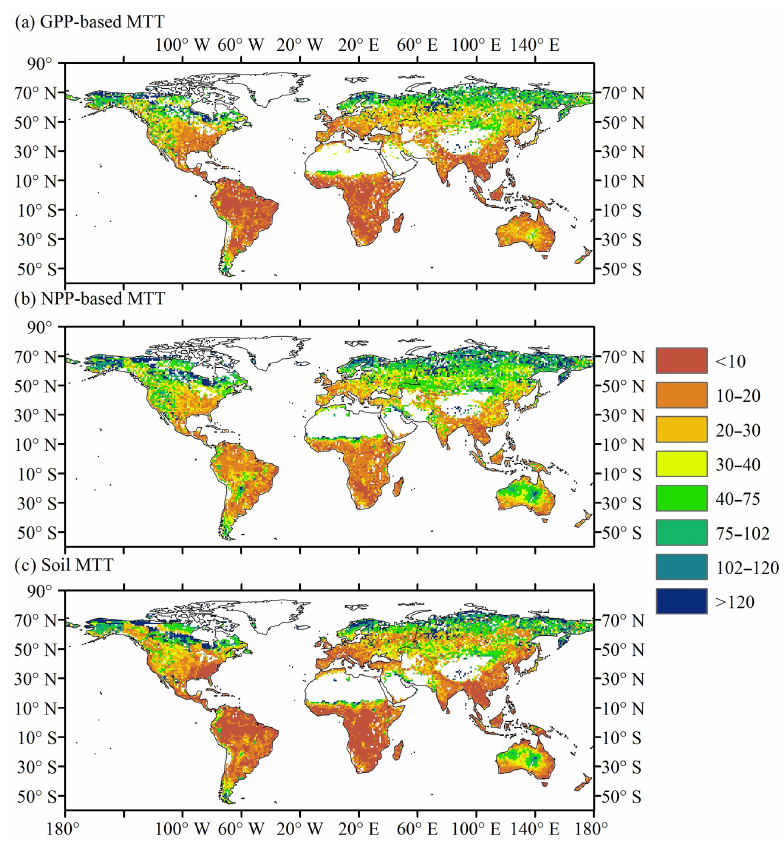
Figure 2. Spatial pattern of mean turnover time (MTT, years) based on biome types and GPP (a) , NPP (b) and soil C (c) using the C balance